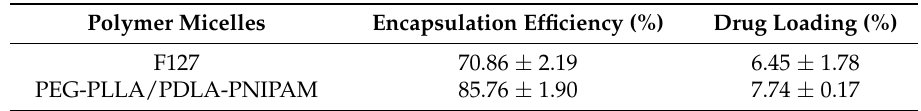
Table 2. Encapsulation efficiency and drug loading of PEG-PLLA/PDLA-PNIPAM drug-loaded micelles ( n = 3).